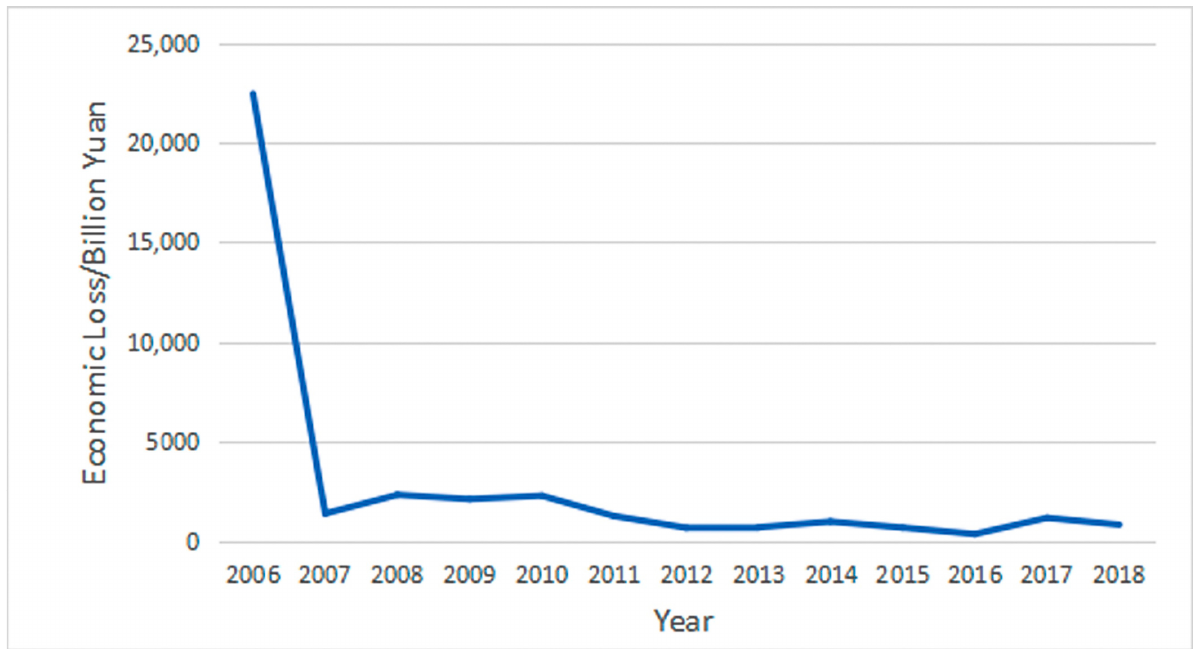
Figure 1. Changes in economic loss caused by forest fires in China from 2006 to 2018.